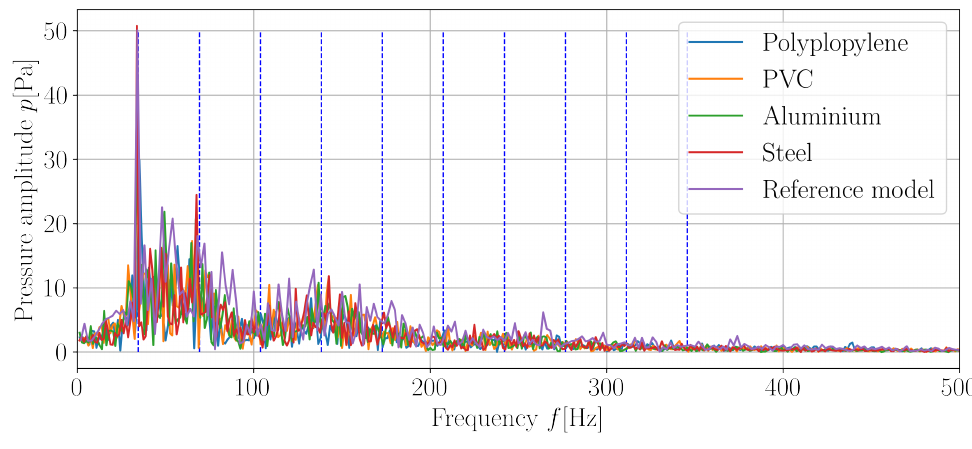
Figure 8. Spectrum of flow pressure at point F3 (Figure 1) ( Rossiter